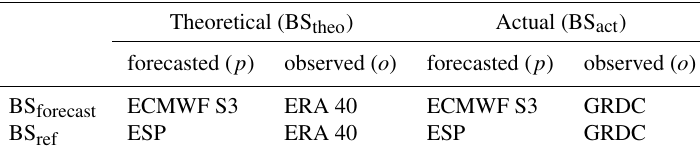
Table 2. Meteorological datasets used for calculating